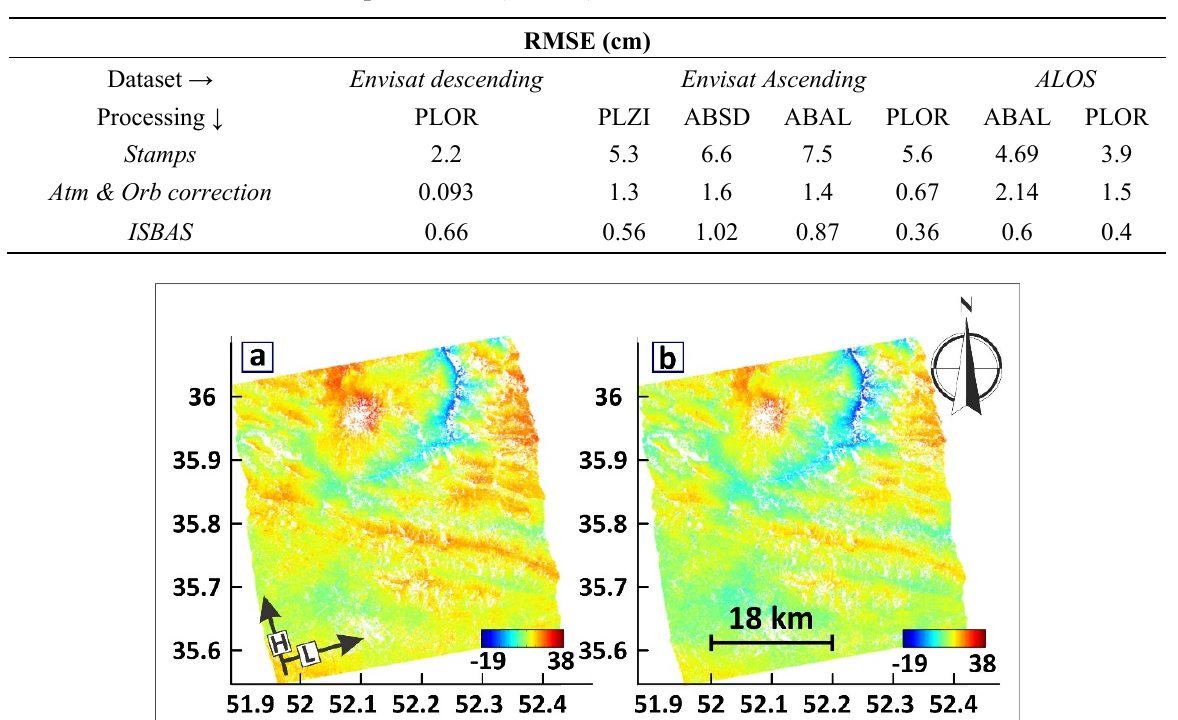
Figure 20. ALOS velocity map before performing atmospheric correction derived from ( a ) standard 3D unwrapping without topographic correction and ( b ) modified 3D unwrapping with topographic correction. The unit of the colorbar is